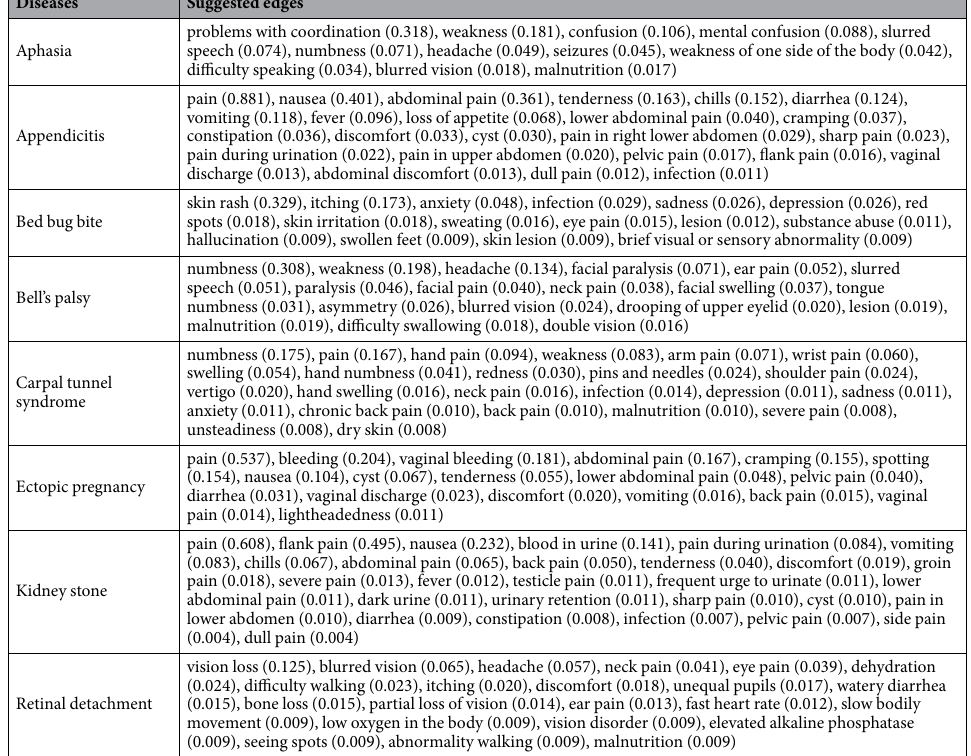
Table 3. Subset of the knowledge graph learned using the noisy OR model. For each disease we show the full list of edges along with their corresponding importance score in parentheses. Symptoms are ordered according to importance